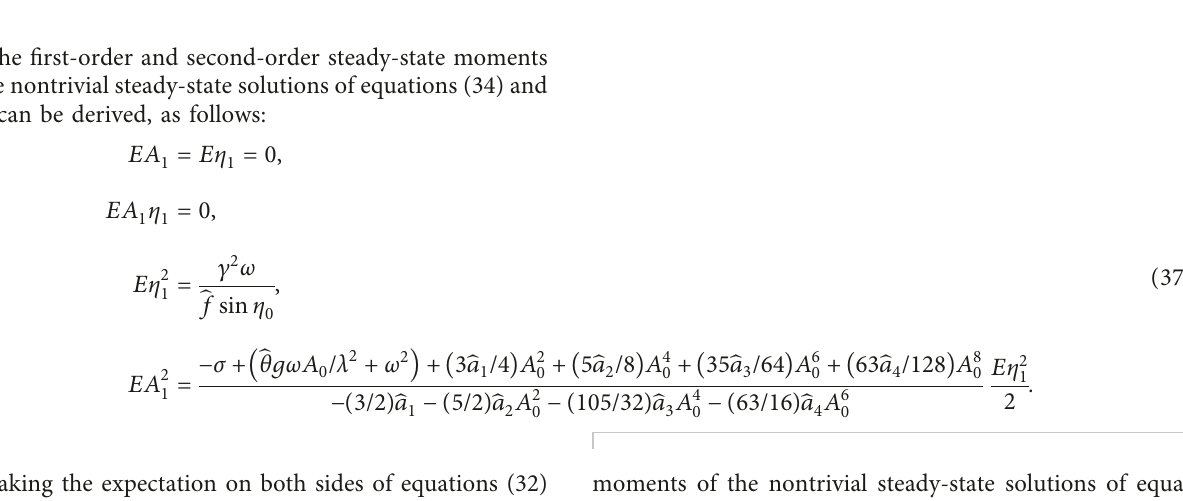
Figure 4: Time-domain response displacement of the multistable energy harvester: (a) 􏽢 f � 1 . 5; (b) 􏽢 f � 0 .